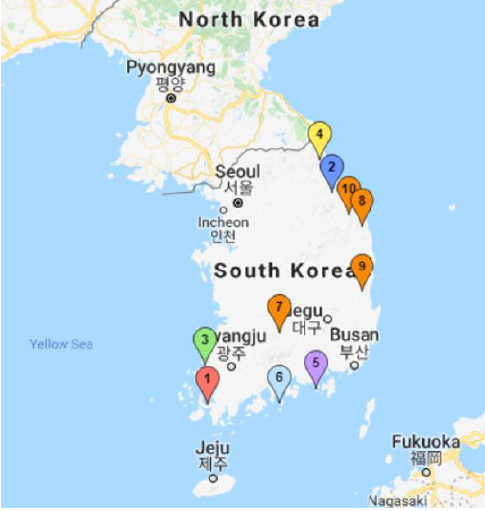
Figure 4. Proposed onshore wind farm site locations on map [22,23] .